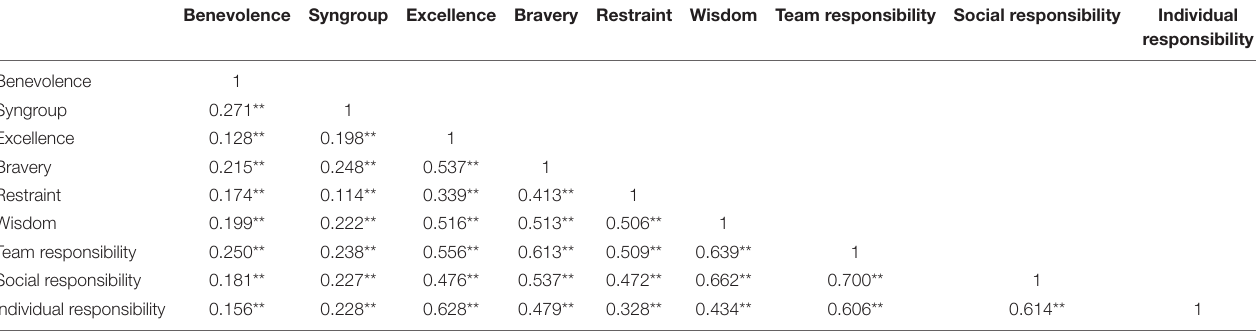
TABLE 10 | Correlation analysis between positive quality and responsibility for innovation and entrepreneurship.